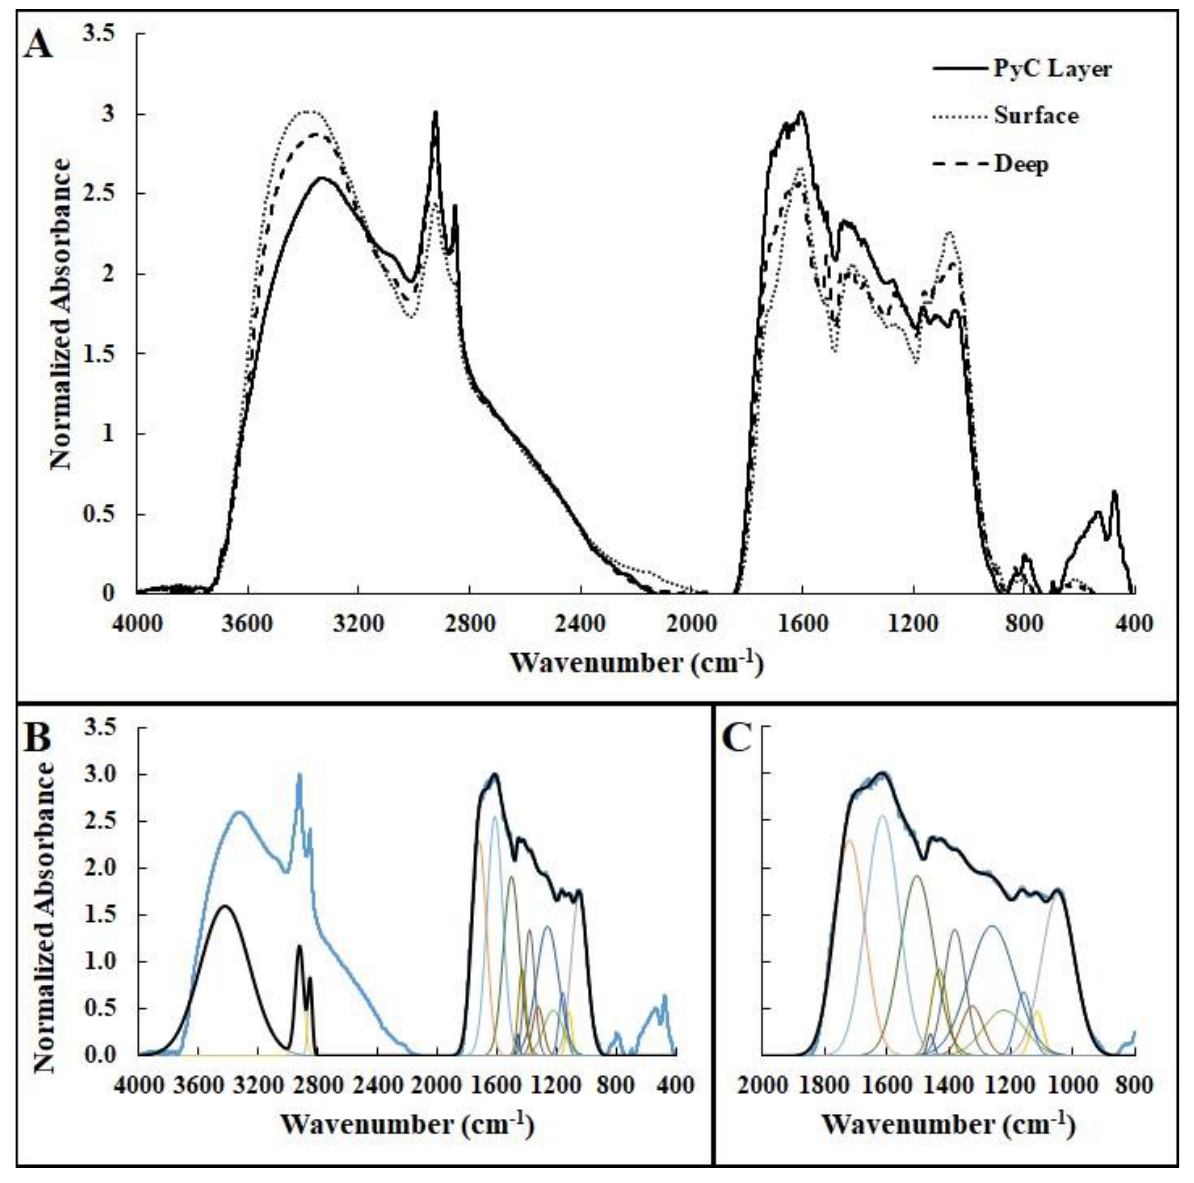
Figure 2. Plot A shows the FTIR spectra of three prototypical samples. The PyC layer is from the Sleeper Lake peatland fire in Michigan, USA. The surface and deep samples are without added PyC; their origins are explained in the admixture preparation subsection of Methods. Plots B and C show the peak fitting results for the PyC sample. Plot B shows the whole spectrum. Plot C shows a detail view of the fingerprint region. In both B and C, the blue line is the original spectrum and the black line is the best fit line built by summing the values of all Gaussian peaks (coloured peaks) fitted to the